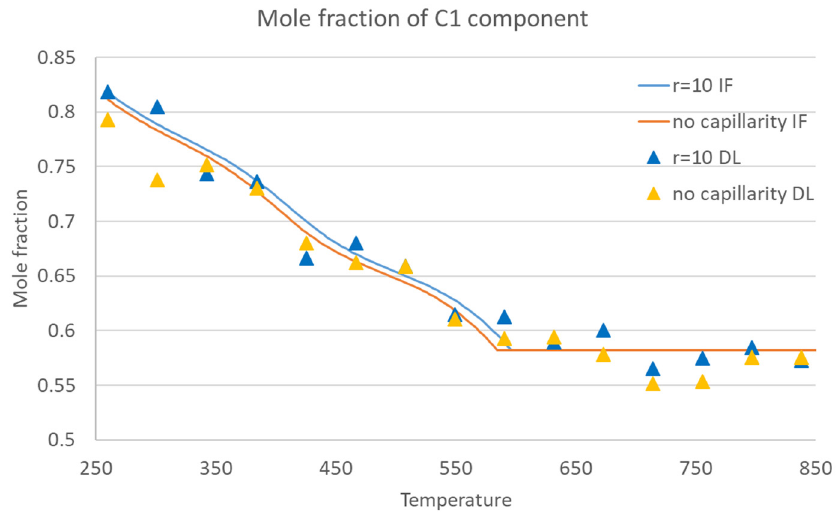
Figure 7. Mole fractions of C1 component in the vapor phase changing with temperature under the constant overall mole concentration as 189.85 mol/m 3.